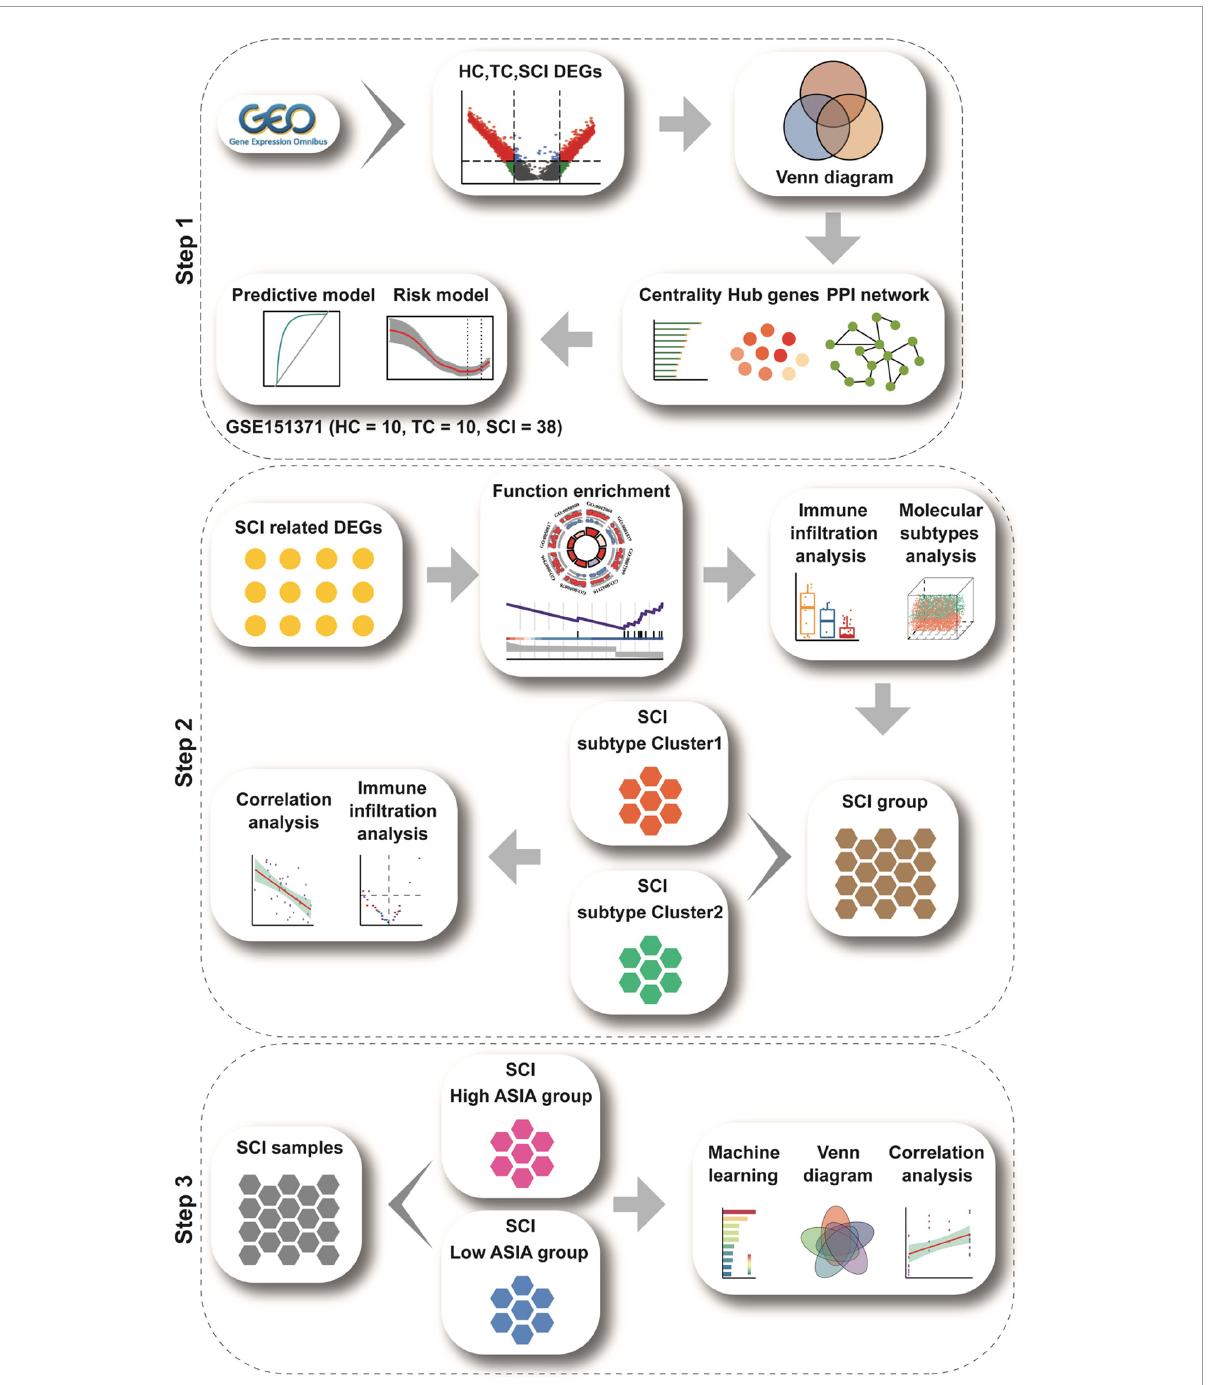
FIGURE1 Study flow chart. The study flow chart is divided into three main sections according to the study sequence. Each icon represents schematically an analysis or a collection of data to be analyzed.